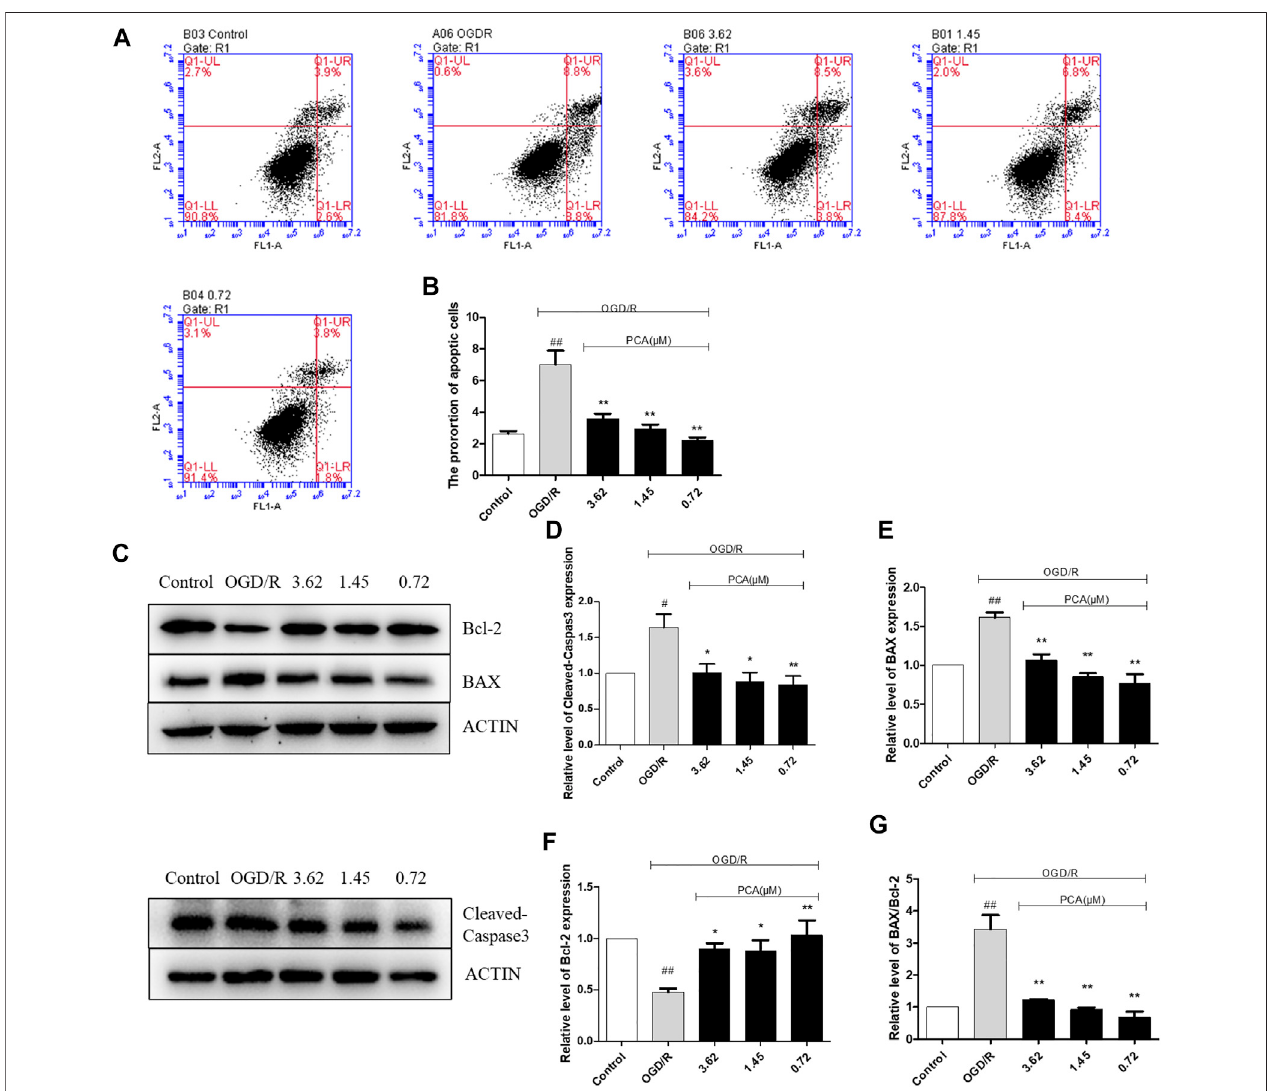
FIGURE 4 | PCA regulated HUVECs apoptosis. (A, B) Representative images of fl ow cytometry analysis of PCA in fl uence and quanti fi cation of cell apoptosis rate. (C – G) RepresentativeimagesofWBanalysisandthesemi-quanti fi cationofCleaved-Caspase3,BAXandBcl-2inHUVECs.Thevaluesareexpressedasthemean±SD ( n = 3). ## p < 0.01 vs. Control, ** p < 0.01, * p < 0.05 vs.